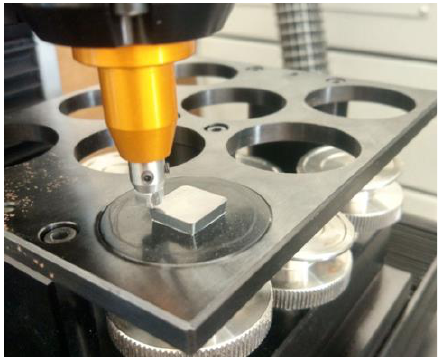
Figure 2. The Qness 10A microhardness tester used for applying the microtextures.